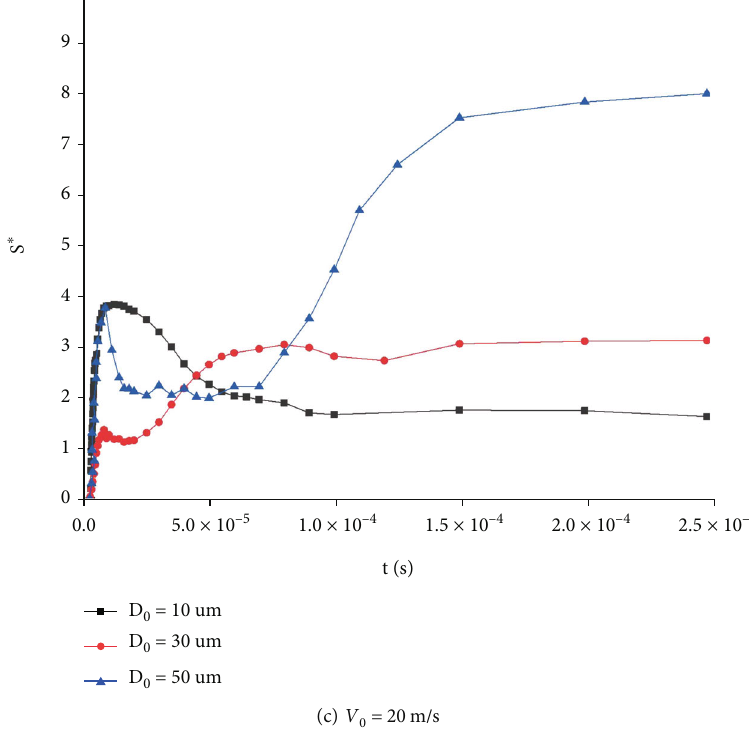
Figure 4: Dimensionless spread area of droplets with di ff erent particle sizes over